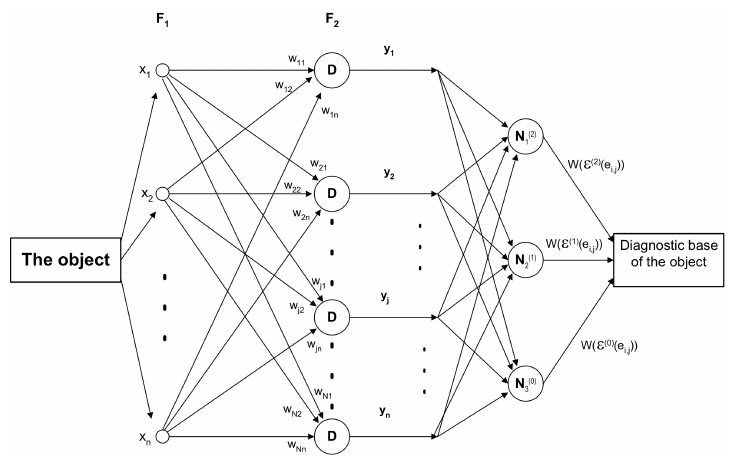
Figure 2. Structure of an artificial neural network in the DIAG